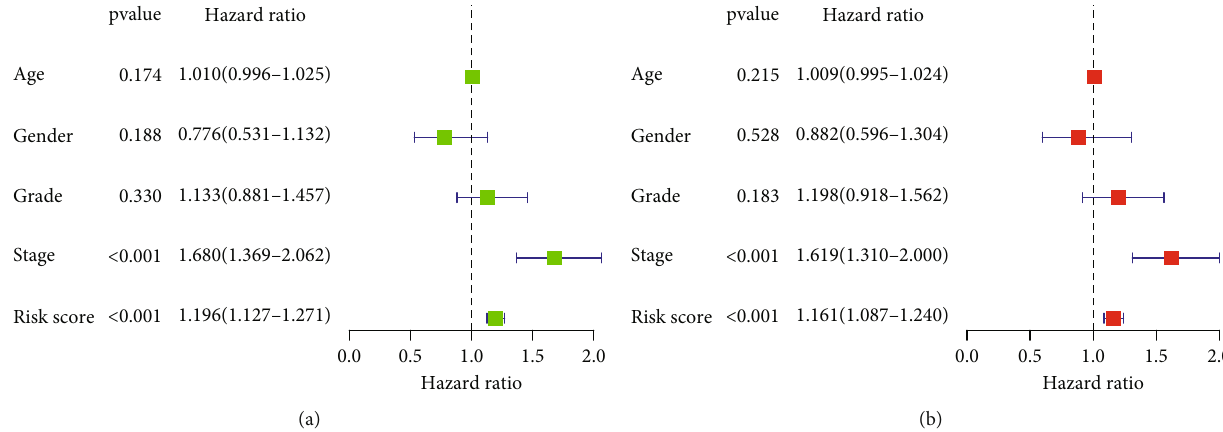
Figure 4: Univariate (a) and multivariate (b) assays were applied to further con fi rm the prognostic value of the 7-gene signature.